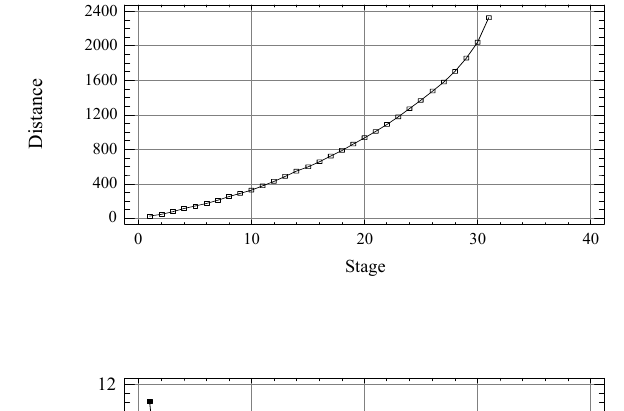
Fig. 4. As Fig. 2, for summer.